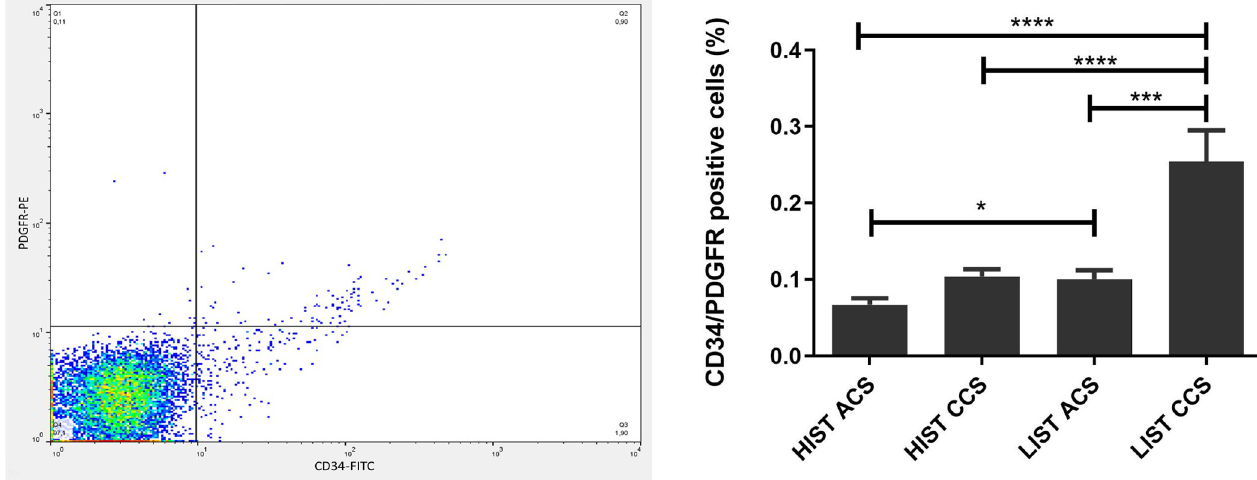
Fig 6. Depleted percentages of CD34+/PDGFR+ cells under HIST. Statin intensity impact on CD34 + /PDGFR + cells detected by FACS demonstrated lower percentages in patients under HIST (right). Double fluorescence with PE-labelled PDGFR and FITC-labelled CD34 antibodies; double positive cells are indicated in the upper right quadrant